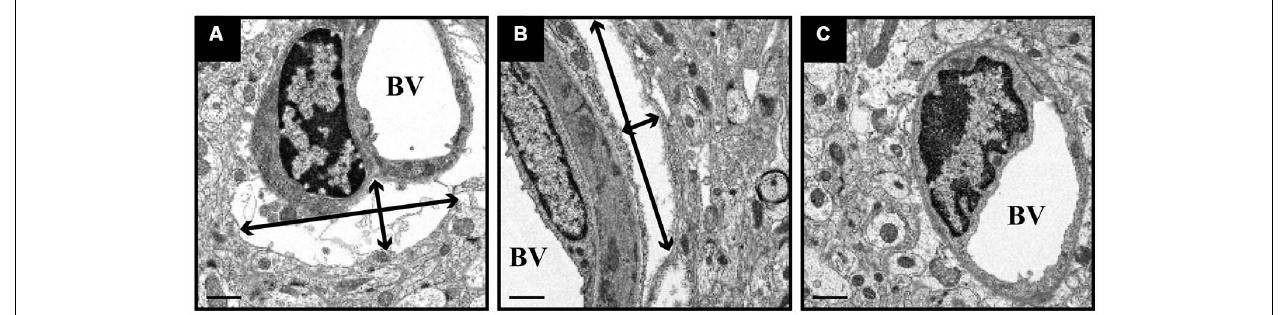
FIGURE 4 | Expansion of perivascular spaces after CED. PBS-infused tissue was processed for EM and revealed the expansion of perivascular spaces after CED.These spaces ranged in size from 11 μ m (width) × 3 μ m 1 μ m.